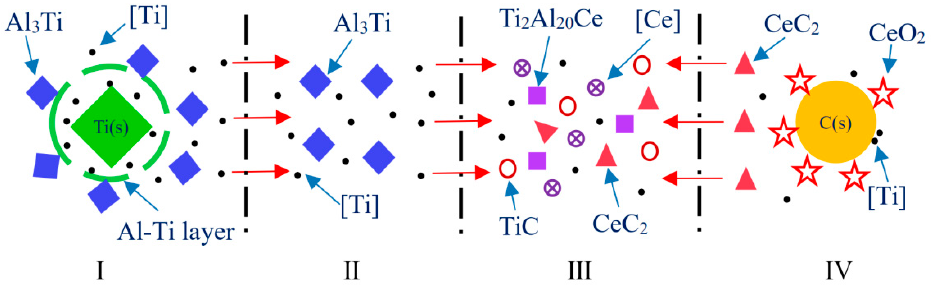
Figure 9. Microscopic kinetics mechanism model of TiC synthesis in Al-Ti-C-Ce system. I: 3Al(l) + Ti(s) → Al 3 Ti(s); II: Al 3 Ti(s) → [Ti] + 3Al(l); III: CeC 2 (s) + 2[Ti] → 2TiC(s) + [Ce]; IV: CeO 2 (s) + 6C(s) + 2O 2 (g) → CeC 2 (s) + 4CO(g).